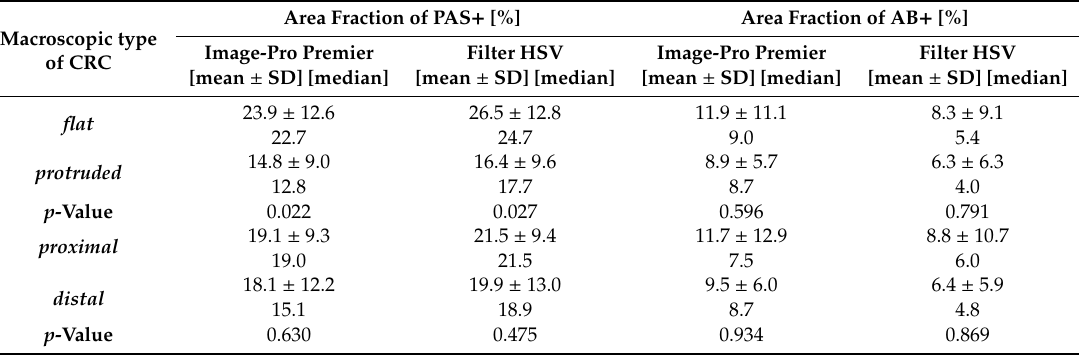
Table 4. Comparison of PAS + and AB + polysaccharides expression in flat / protruded macroscopic types of colorectal carcinoma, as well as proximal / distal localized CRC (A%). Macroscopic type of CRC